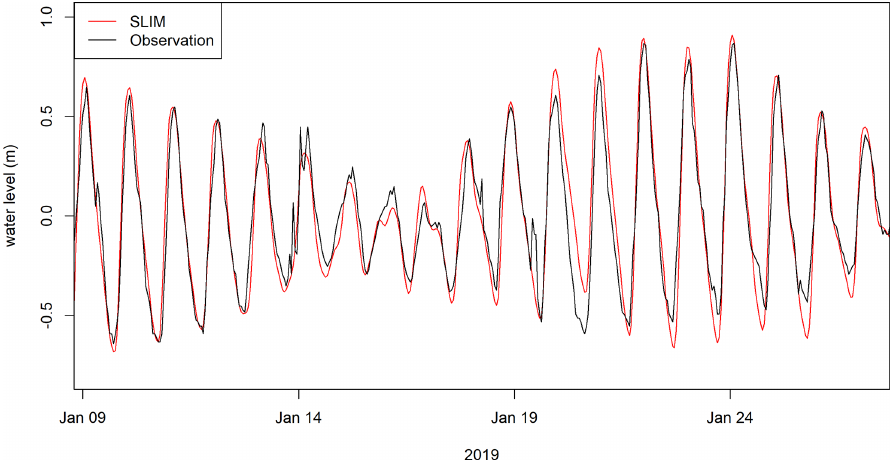
Figure 5. The SLIM 2D model’s output validation with respect to observational data at Pontianak in January 2019, with NSE = 0 . 87 and RMSE = 0 . 12m, indicating that the model has satisfactory